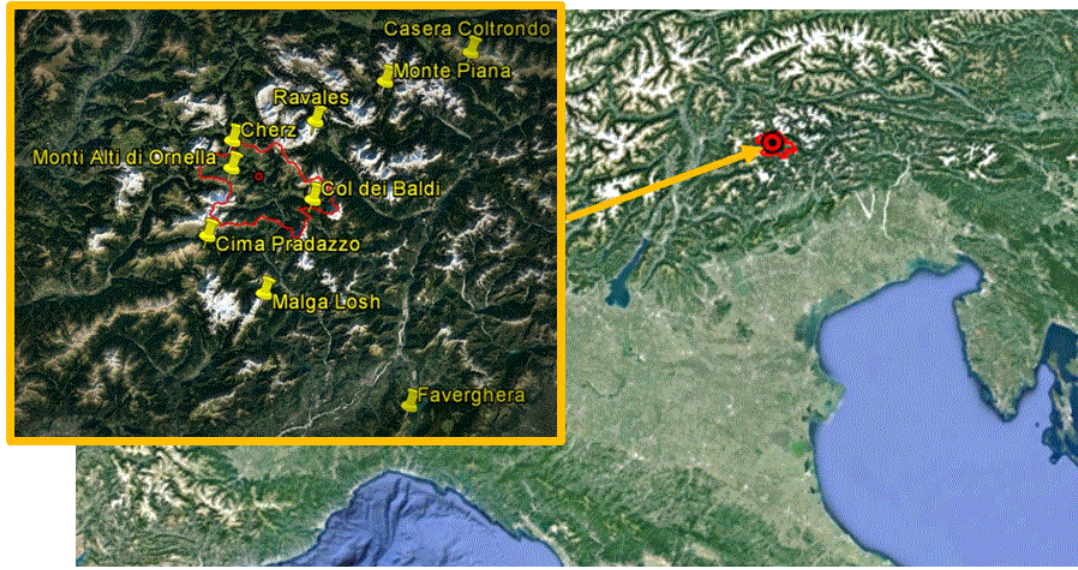
Figure 1. Cordevole basin in the North-eastern Italian Alps. Yellow placemarks indicate the meterological stations present on the area: (1) Col dei Baldi (1900 m a.s.l.); (2) Casera Coltrondo (1899 m a.s.l.); (3) Cima Pradazzo (2200 m a.s.l.); (4) Faverghera (1605 m a.s.l.); (5) Monti Alti di Ornella (2250 m a.s.l.); (6) Cherz (2100 m a.s.l.); (7) Ravales (2615 m a.s.l.); (8) Monte Piana (2265 m a.s.l.); (9) Malga Losch (1735 m a.s.l.). The red line represents the borders of the Cordevole basin.